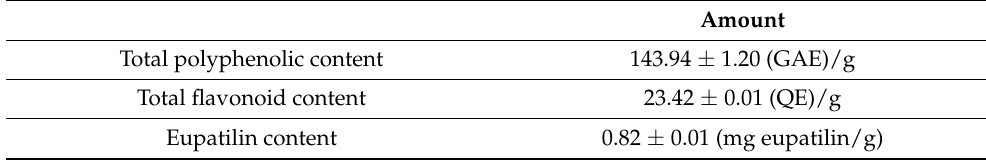
Table 1. Total phenolic, flavonoid, and eupatilin content in the Artemisiae argyi water